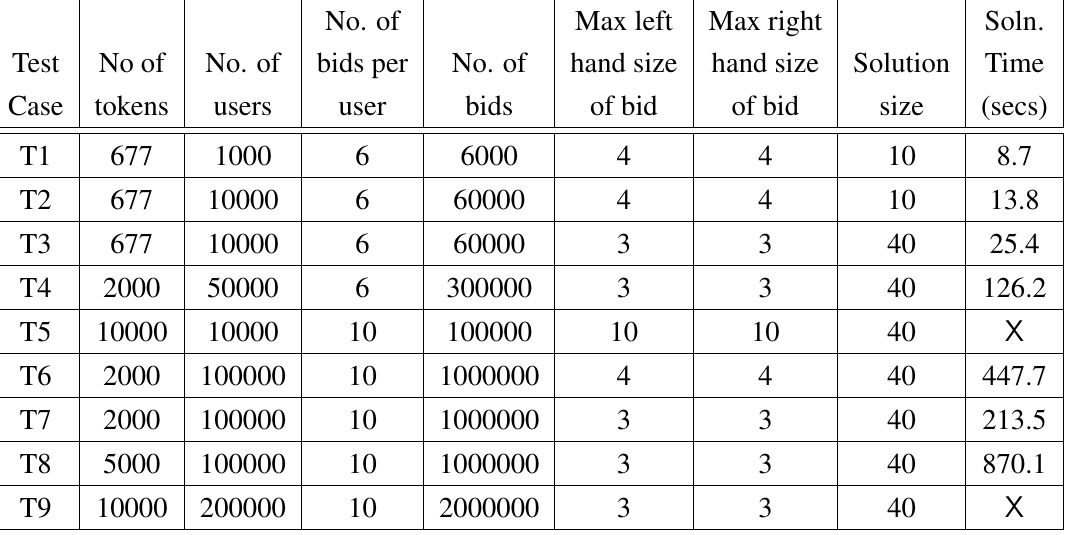
Table 4. Gurobi solution times for some problem instances with time limit of 20 minutes No. of Max left Max right